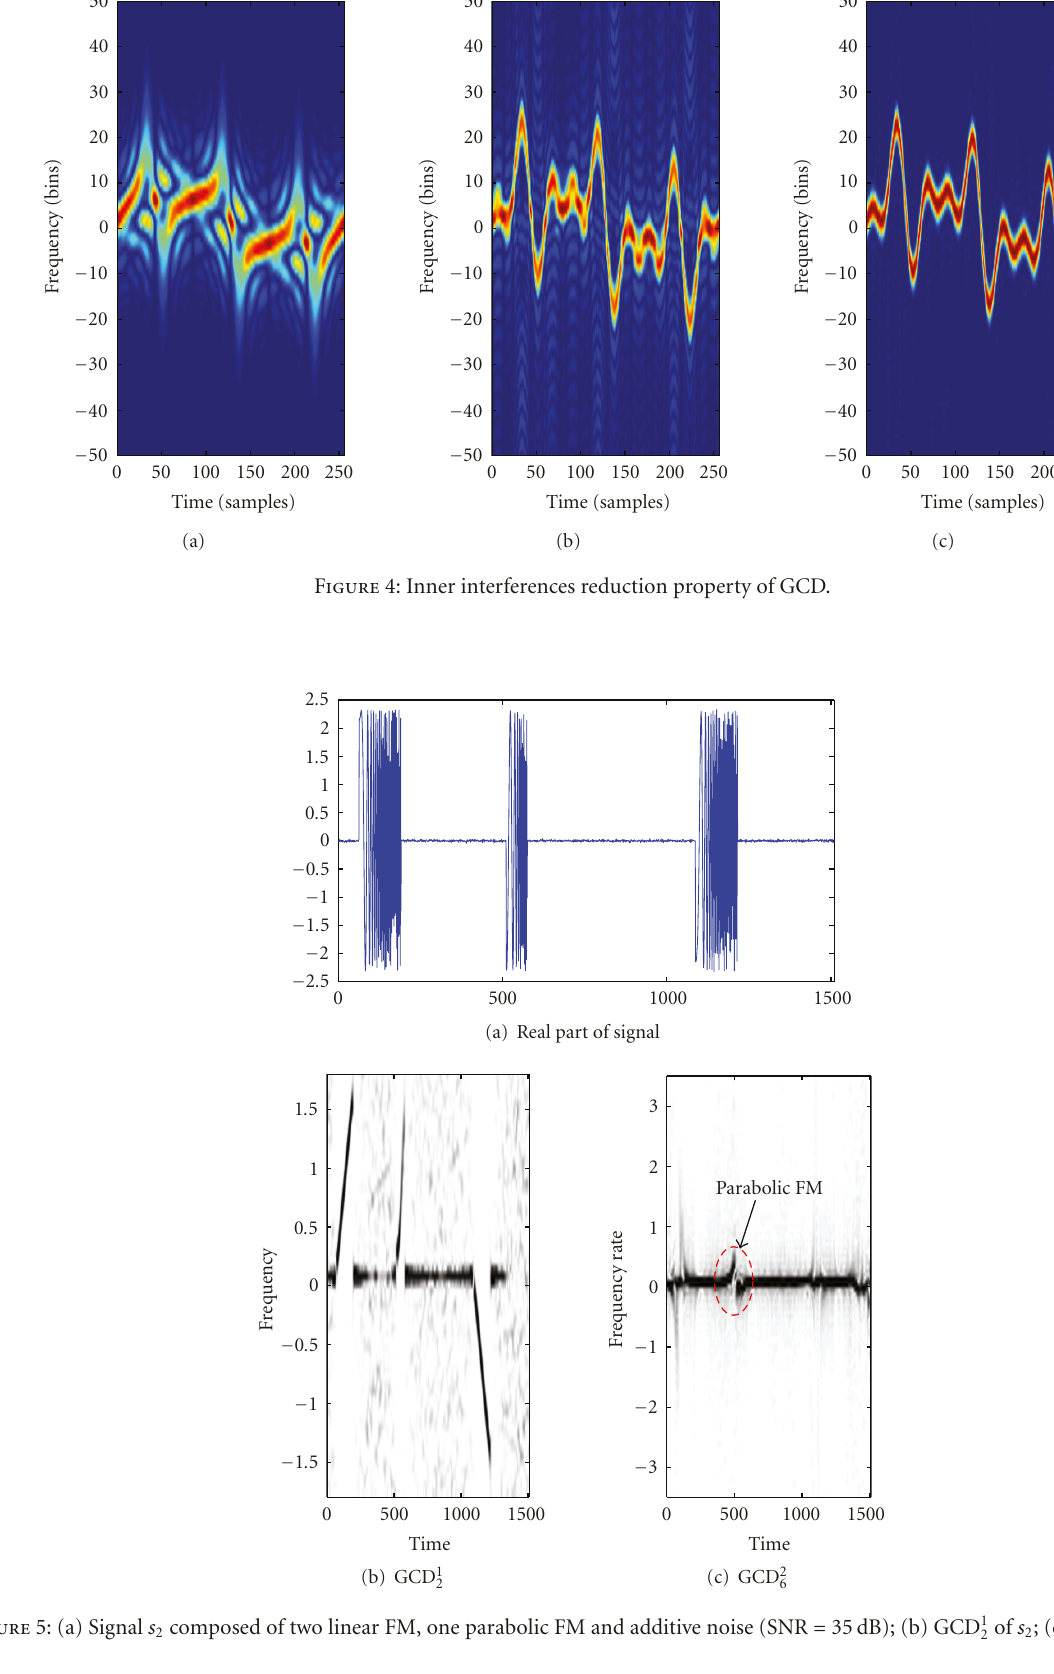
of s 2 ; (c) GCD 2 of s 2 2 6